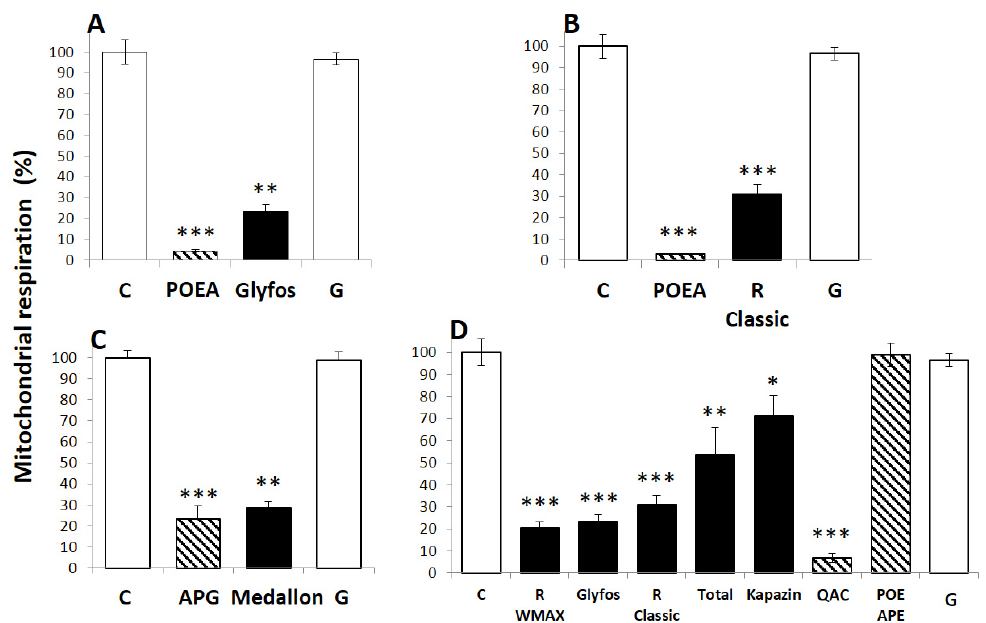
Figure 2. Inhibition of cell respiration by co-formulants and formulations at similar levels. * p < 0.05, ** p < 0.01, *** p < 0.001. ( A ) 100 ppm of Glyfos is compared to the content in POEA (10 ppm) and G (48.6 ppm); ( B ) 100 ppm of Glyfos is compared to the content in POEA (10 ppm) and G (48.6 ppm); ( C ) 2000 ppm of Medallon is compared to the content in APG (800 ppm) and G (975 ppm); ( D ) 100 ppm of the formulations are compared to the content in G (48.6 ppm). Two co-formulants were also tested around their LC 50 (QAC, 58 ppm; POE-APE, 222 ppm, see Table 1).